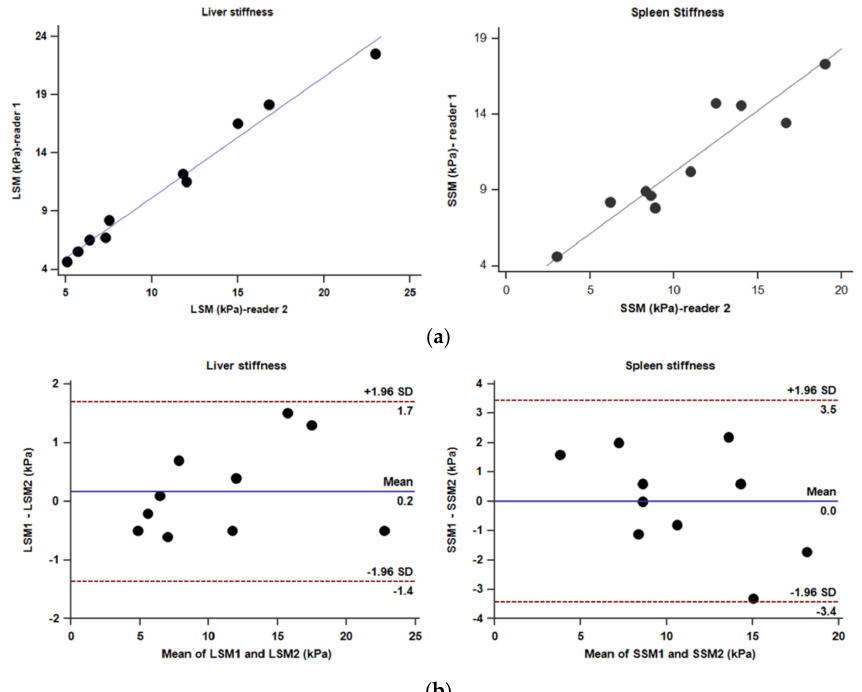
Figure 1. ( a ) Scatter plots showing excellent correlation between two independent readers for liver stiffness ( r = 0.99) and spleen stiffness ( r = 0.94). ( b ) Bland–Altman plots for liver stiffness and spleen sti ff ness. (LSM = liver sti ff ness measurement; SSM = spleen sti ff ness